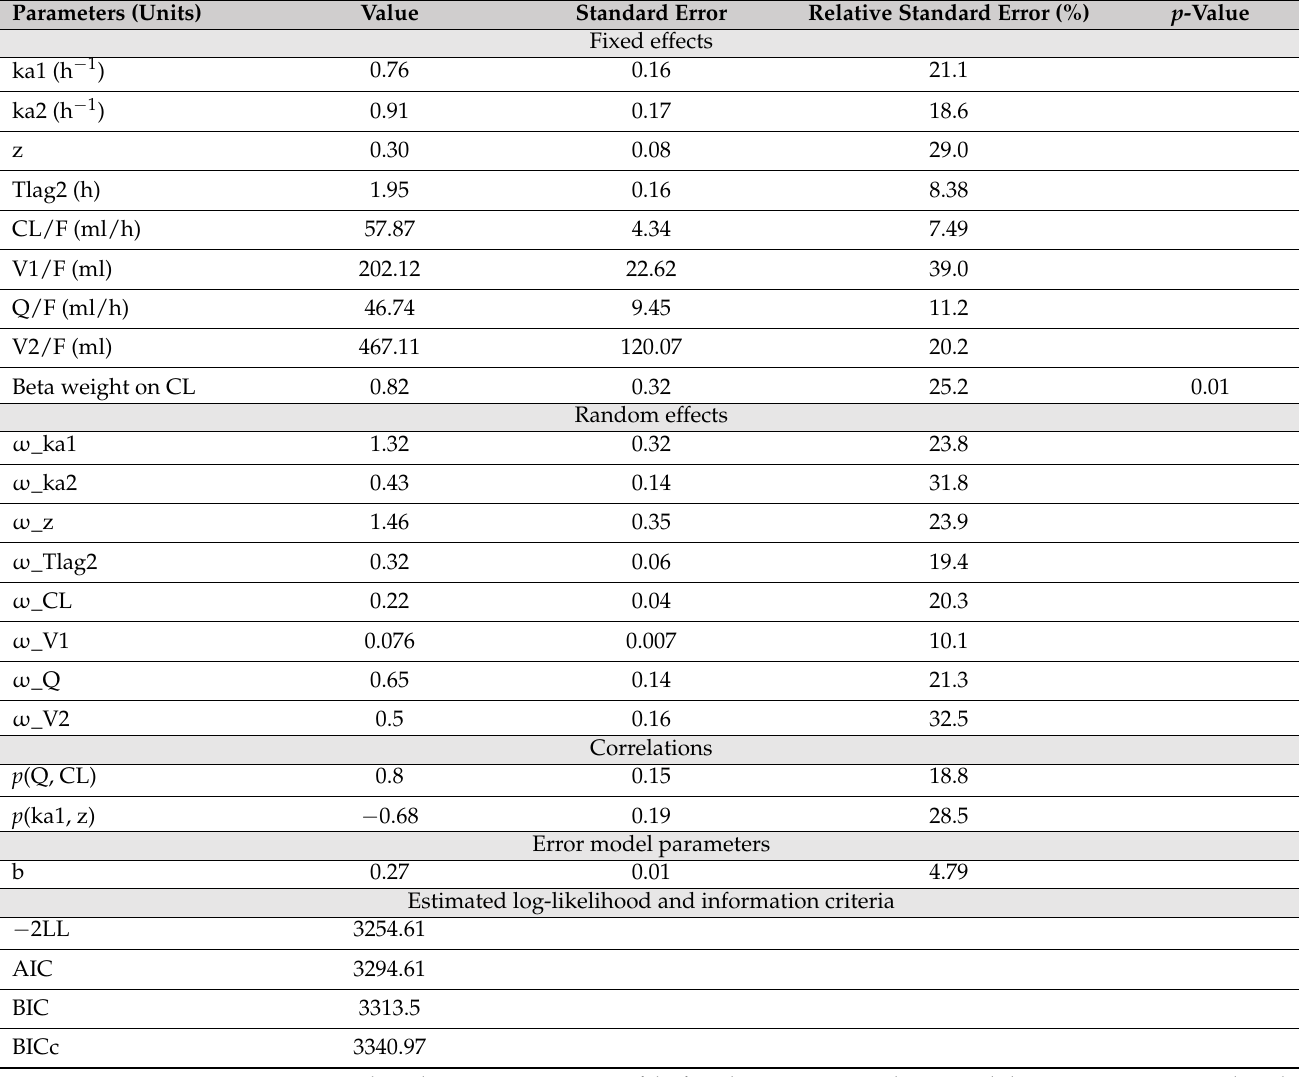
Table 2. Final model parameter